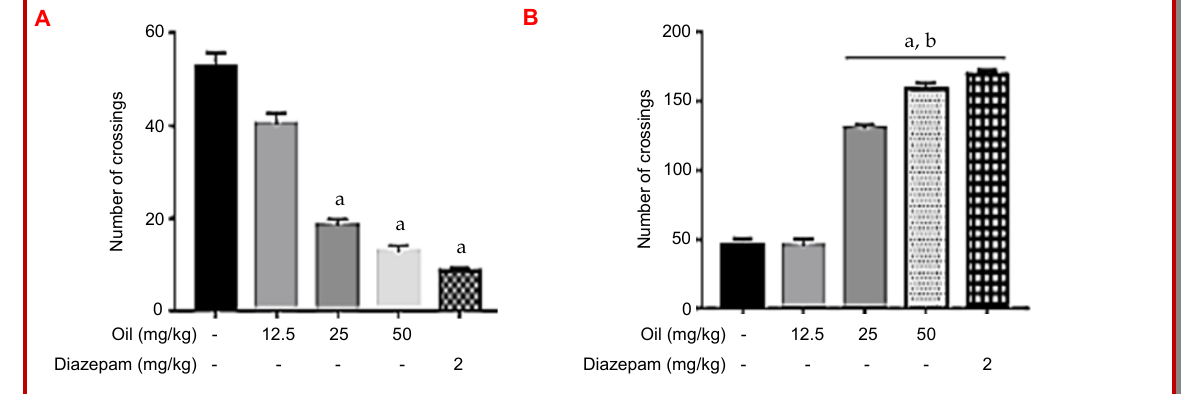
Figure 4: Effect of the essential oil of P. lentiscus in the open field test (n=6 per group). Data are expressed as mean ± SEM, where ‘a’ and ‘b’ p<0,05 indicate difference between control group and essential oil (12.5 mg/kg) respectively. ANOVA one-way followed by post- hoc Tukey’s